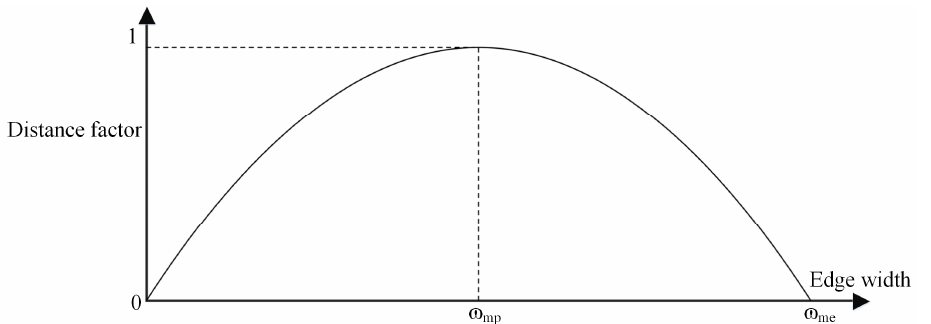
Figure 14. The distance factor variation relationship in Equation (5).